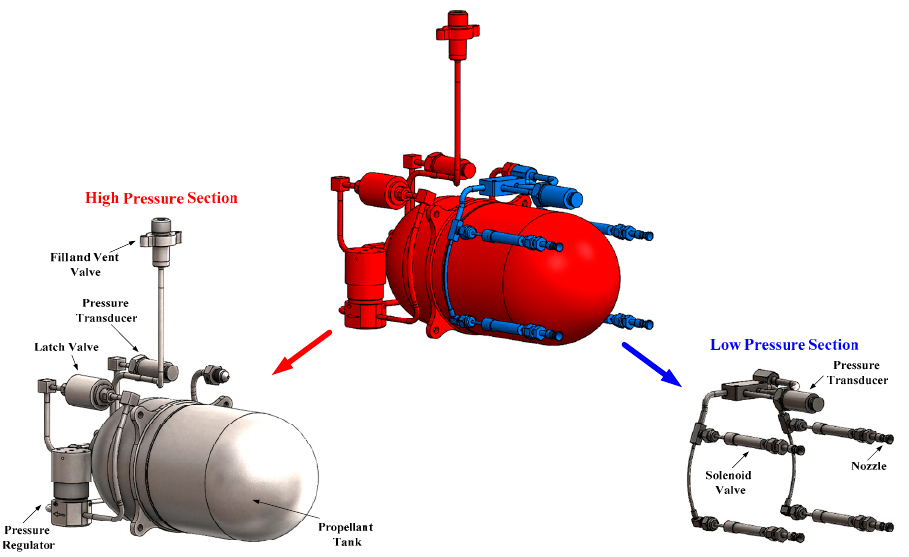
Figure 3. High- ( left ) and low- ( right ) pressure sections of the Adelis-SAMSON propulsion system.